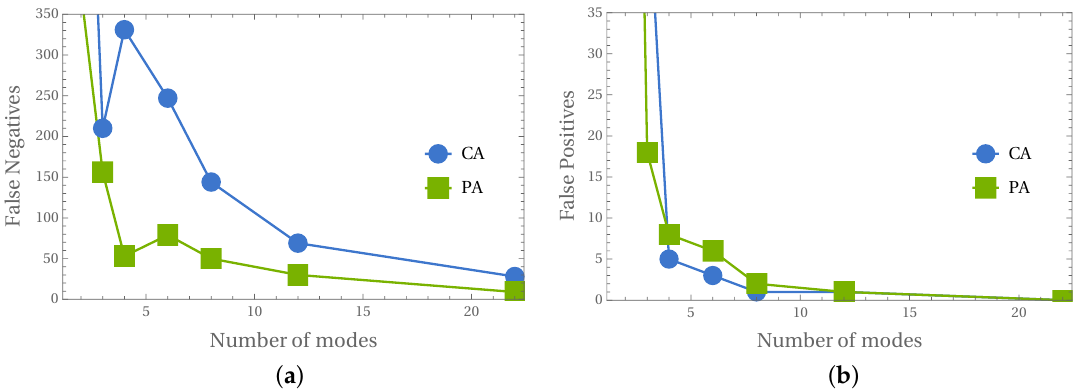
Figure 14. Different number of considered mode shapes in PA and CA: ( a ) false negatives, ( b ) false positives.